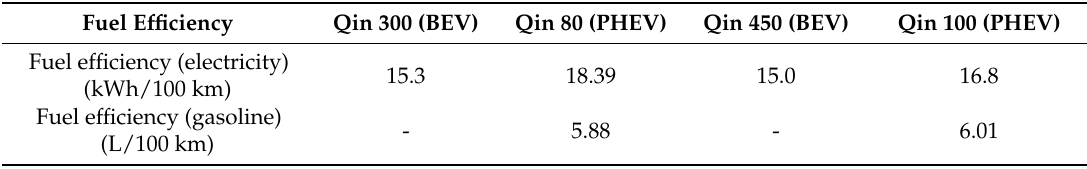
Figure 1. The electricity profile of China in 2017. Table 1. The fuel efficiency of each vehicle technology.